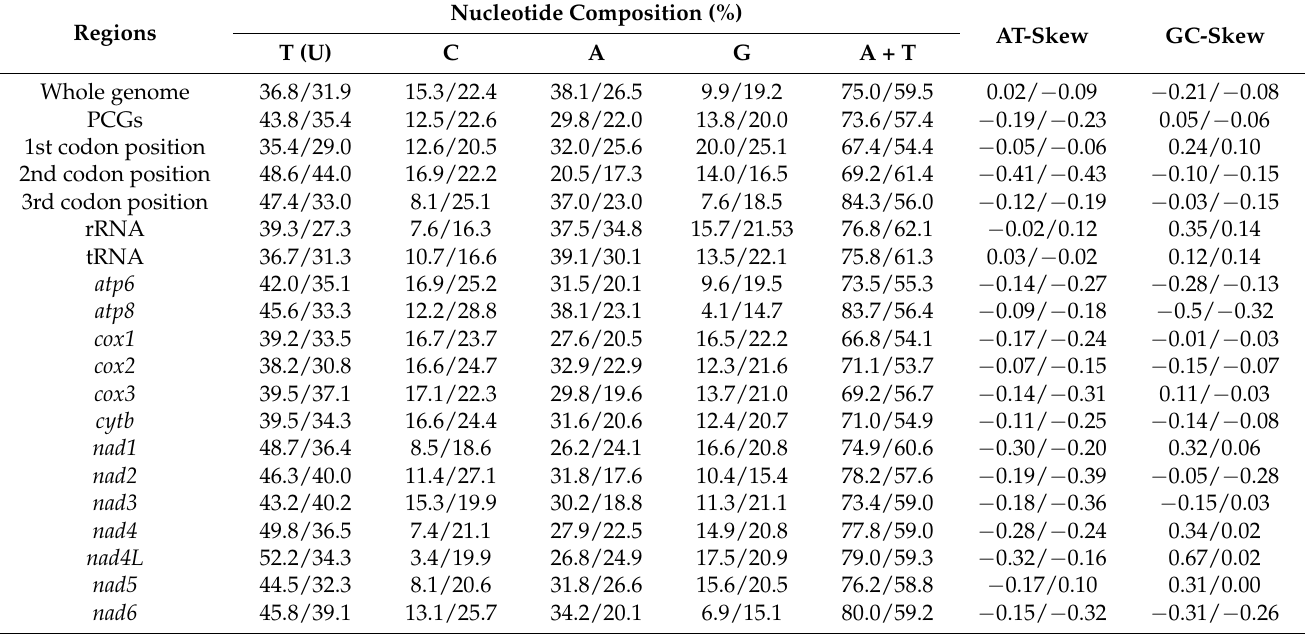
Table 2. Nucleotide composition and skewness levels of L. grossipedia (Laevicaudata)/ Leptestheria brevirostris